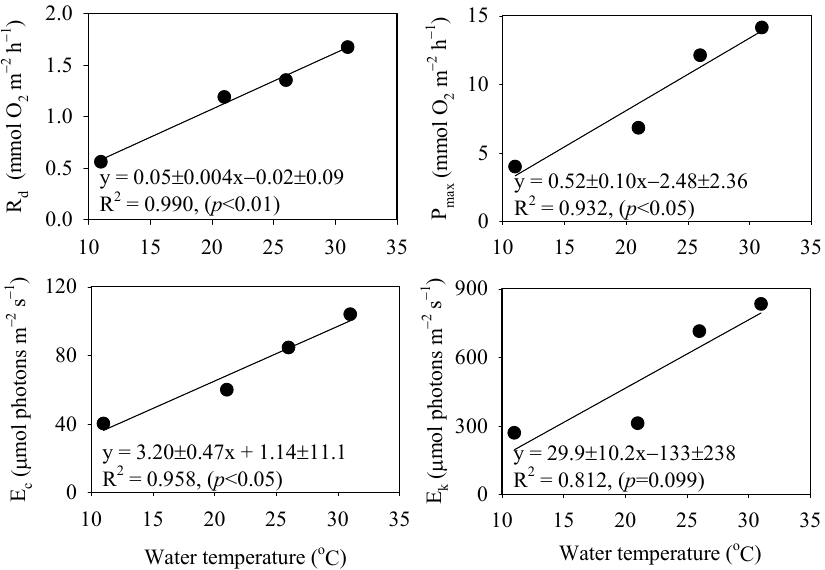
Figure 5. Photosynthesis characteristics–temperature relationships of Pneophyllum fragile .